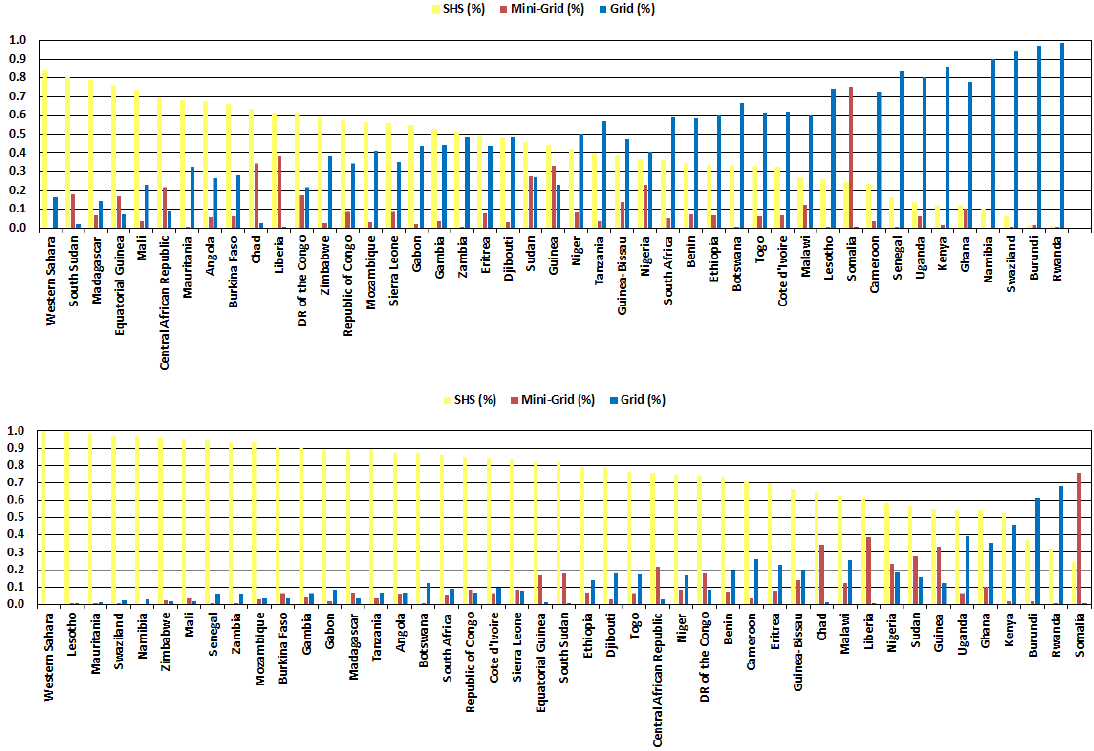
Figure 6. Population share of not yet electrified people to be electrified by SHS, mini-grids and grid extension for excluding ( top ) and including ( bottom ) the population density within the grid buffer zone on basis of the existing grid infrastructure for all countries in sub-Saharan Africa. The detailed numbers are provided in Tables A3 and A4.